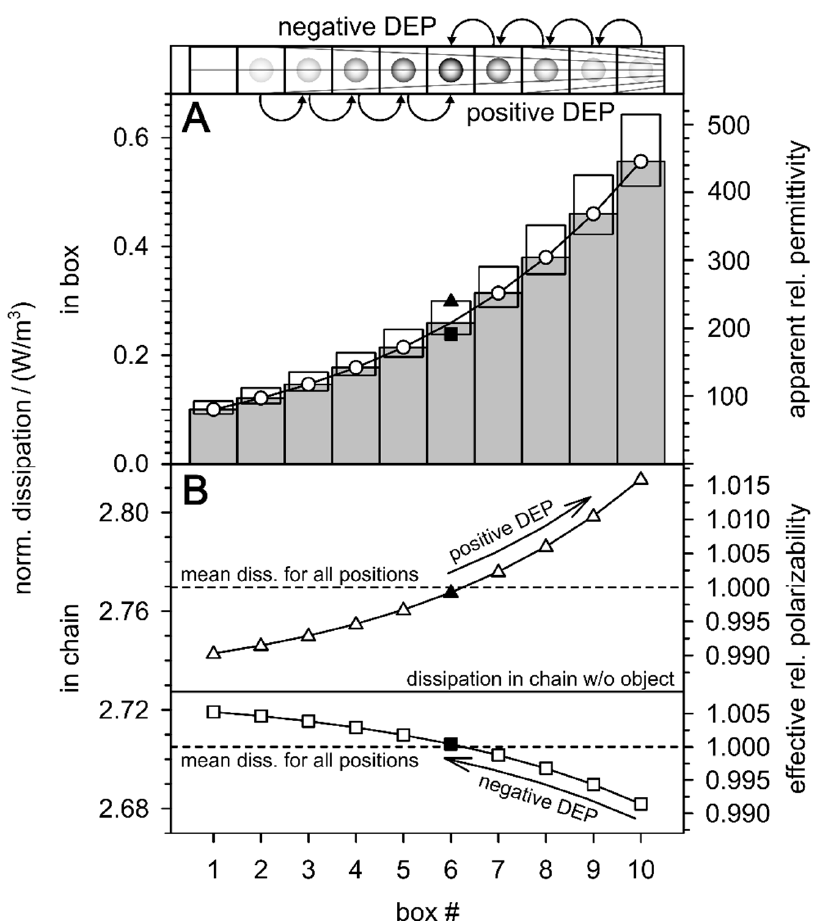
Figure 6. Illustration of DEP-induced changes in field-normalized dissipation in a box chain subjected to an inhomogeneous low-frequency field according to the values of Table 1. ( A ): In the absence of the object, the dissipation in the direction of the field gradient increases with the square of the field strength (circles, gray columns). In the presence of a high (triangles, σ i = 1 S/m) or low polarizable sphere (squares, σ i = 0.01 S/m), the active dissipation in the box is increased or decreased, respectively. The work of charging has the same field strength dependence (Equations (15) and (16)). It is plotted as “apparent relative permittivity” above the right ordinate (see text). ( B ): Dependence of the sum of dissipation in the box chain system on the positions of the single objects. Arrows denote DEP “trajectories”. The dissipations in the chain system (dashed horizontal lines) correspond to effective relative polarizabilities (right ordinate), which are proportional to the charge work of the whole chain system. Effective relative polarizabilities of one correspond to the average dissipation throughout the chain, for an even distribution of the 10 starting positions for the model spheres (dashed horizontal